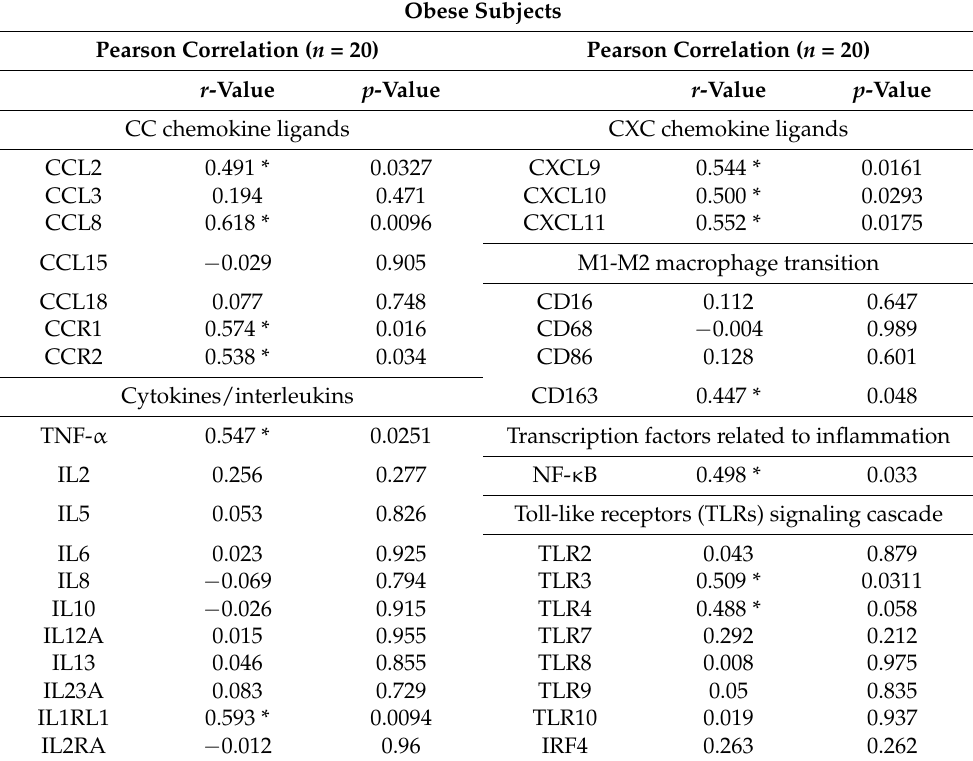
Table 2. Correlation between caveolin-1 gene expression and that of various cytokines or chemokines in non-diabetic obese participants, * p <